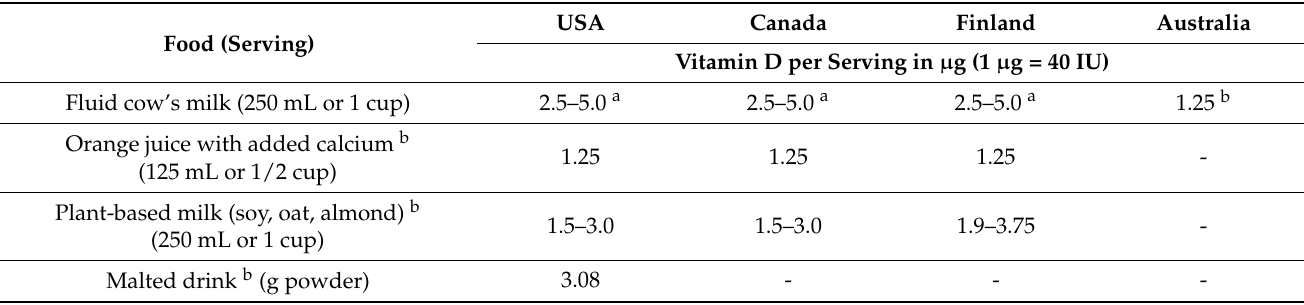
Table 3. Vitamin D-fortified beverages currently practiced worldwide. Adapted from